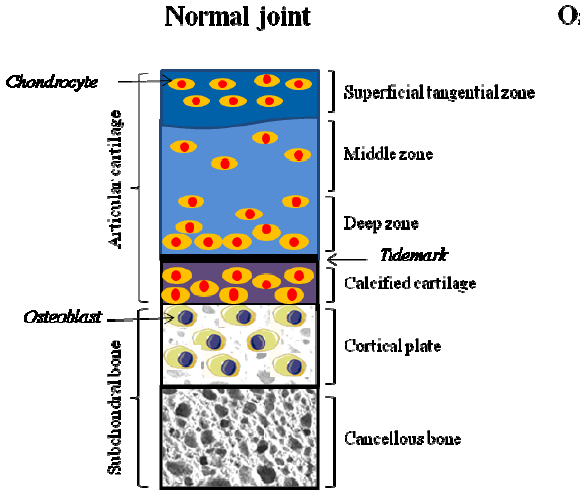
Figure 1. A schematic diagram demonstrating the anatomy of articular cartilage and subchondral bone in normal and osteoarthritis (OA) joints. Normal articular cartilage is divided into superficial tangential zone, middle zone, deep zone, and calcified cartilage zone. These zones consist of a small number of chondrocytes trapped in collagen matrix. Calcified cartilage is separated by a tidemark from the deep zone, and rests directly on subchondral bone. Subchondral bone beneath the articular cartilage is organized into two layers: cortical plate and cancellous bone. Subchondral bone helps to maintain the integrity of the overlying articular cartilage. Alteration in OA joint is represented by collagen matrix disruption in articular cartilage and thickening of subchondral bone. Fissuring and flanking in articular cartilage induces vascularization of cartilage, leading to exposure of subchondral bone to external surface. Microcracks in the subchondral bone contribute to reactivation and upward shifting of the tidemark (demarcation line), representing thin articular cartilage with thick subchondral cortical plate. Subchondral sclerosis is a hall mark of progressive OA. (Figure produced using Servier Medical Art